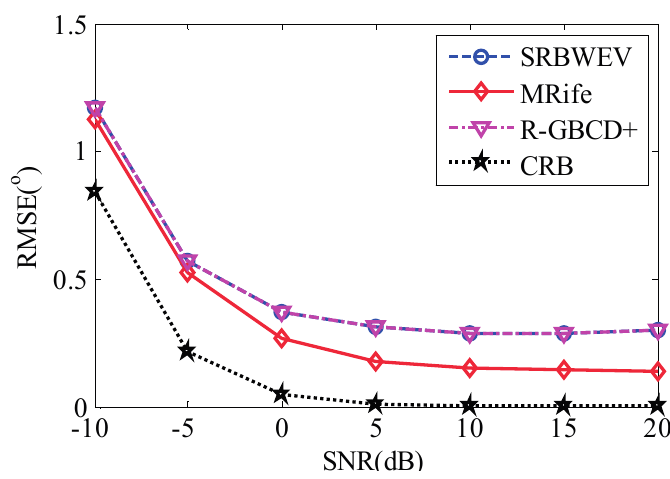
Figure 4. DOA estimation with grid spacing 0.5 ° .